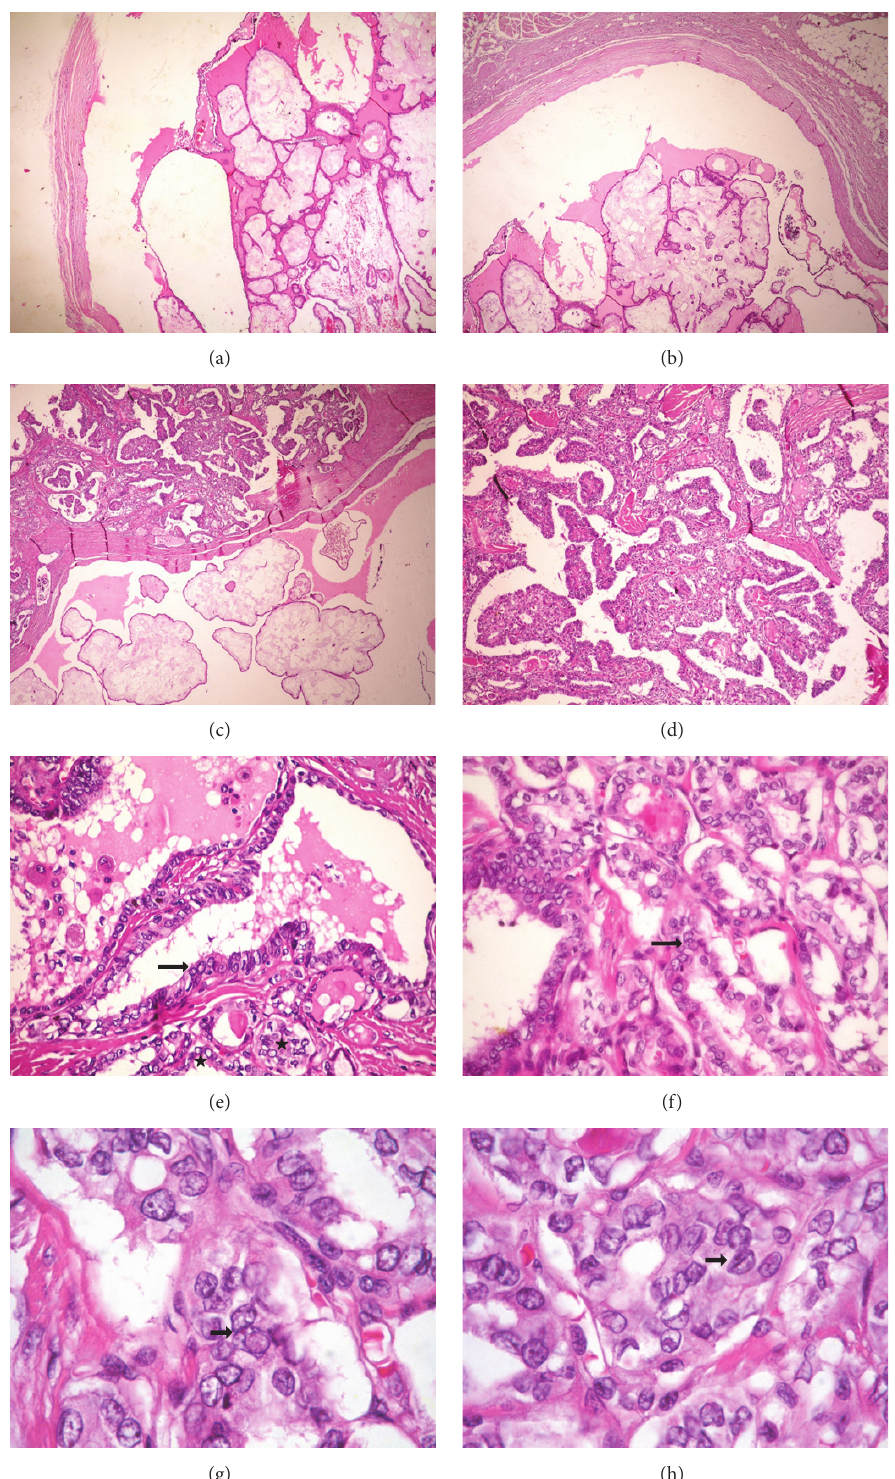
Figure 2: Thyroglossal duct cyst carcinoma. (a) and (b) Low power view of the cyst containing the papillary carcinoma (HE, 40x). (c) The papillaeweresometimesedematous(HE,40x).(d)Thetumorhadpapillae,butalsosomefollicles(HE,100x).(e)Nucleiwithpseudoinclusions (arrow) and ground glass appearance (stars) (HE, 400x). (f) Nuclear pseudoinclusion (HE, 400x). (g) Nuclear pseudoinclusion (arrow) (HE, 1000x). (h) Nuclear groove (arrow) (HE,